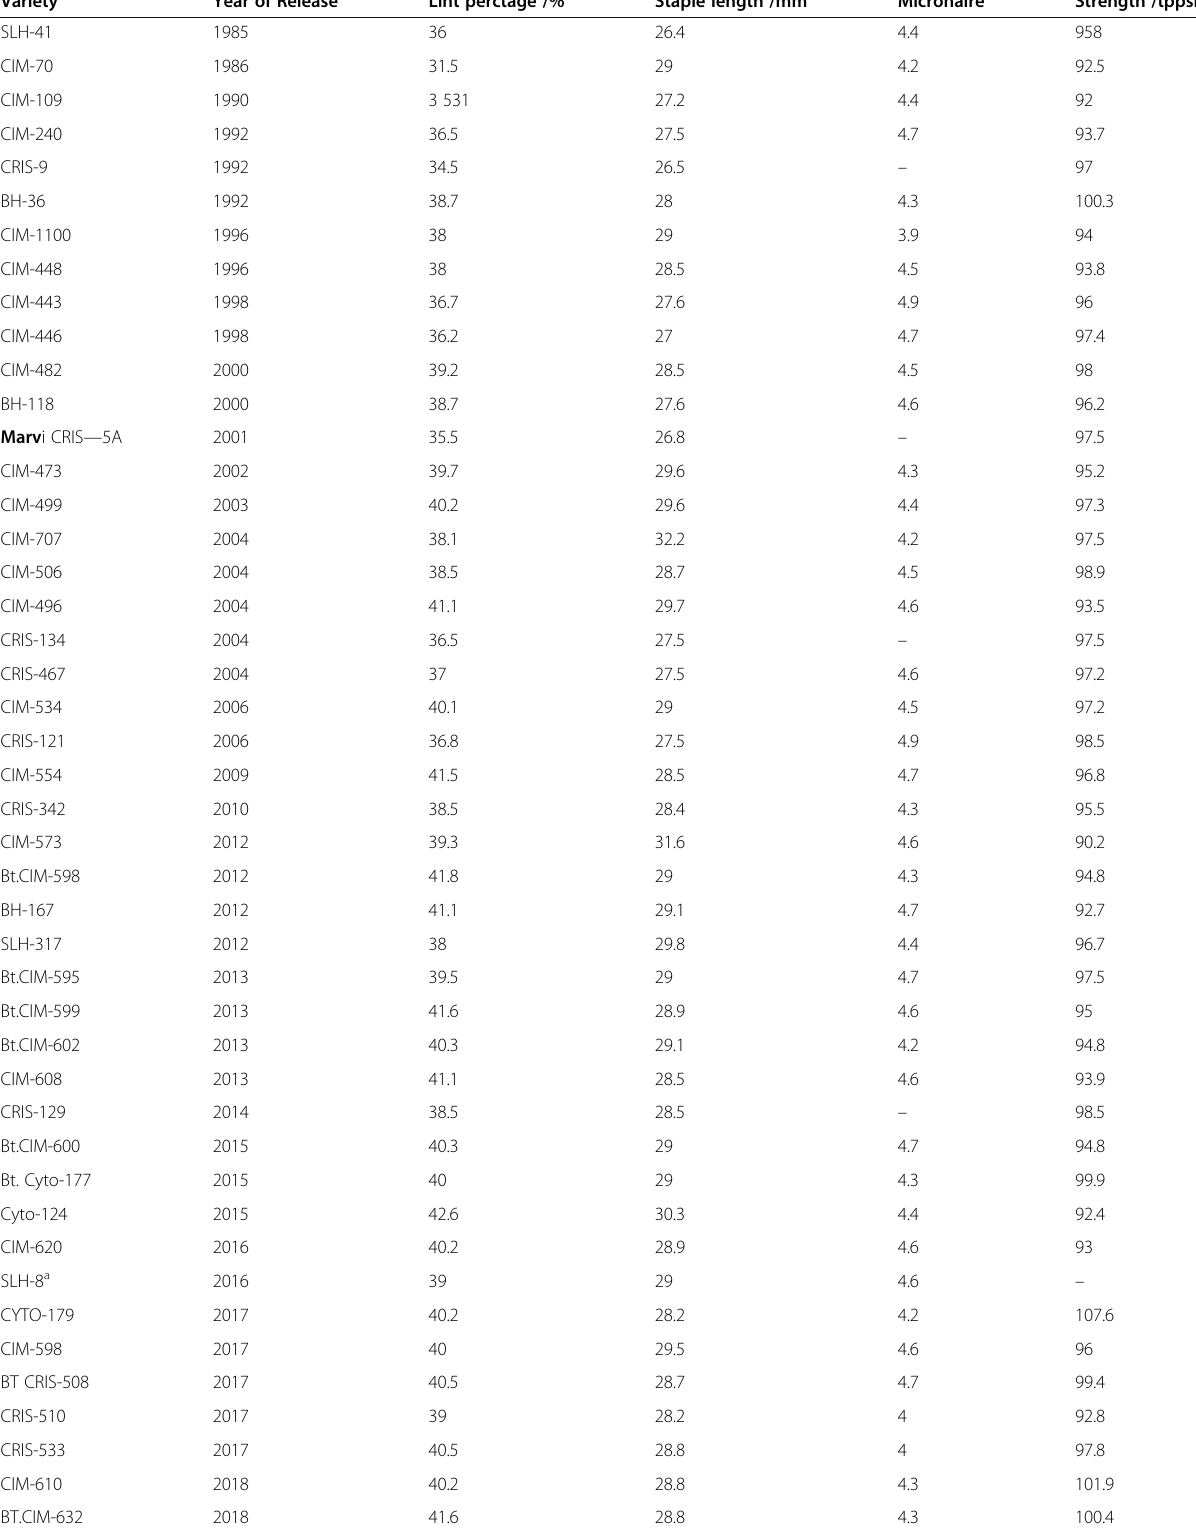
Table 3 Cotton varieties developed by PCCC (1985 – 2018) and their fiber